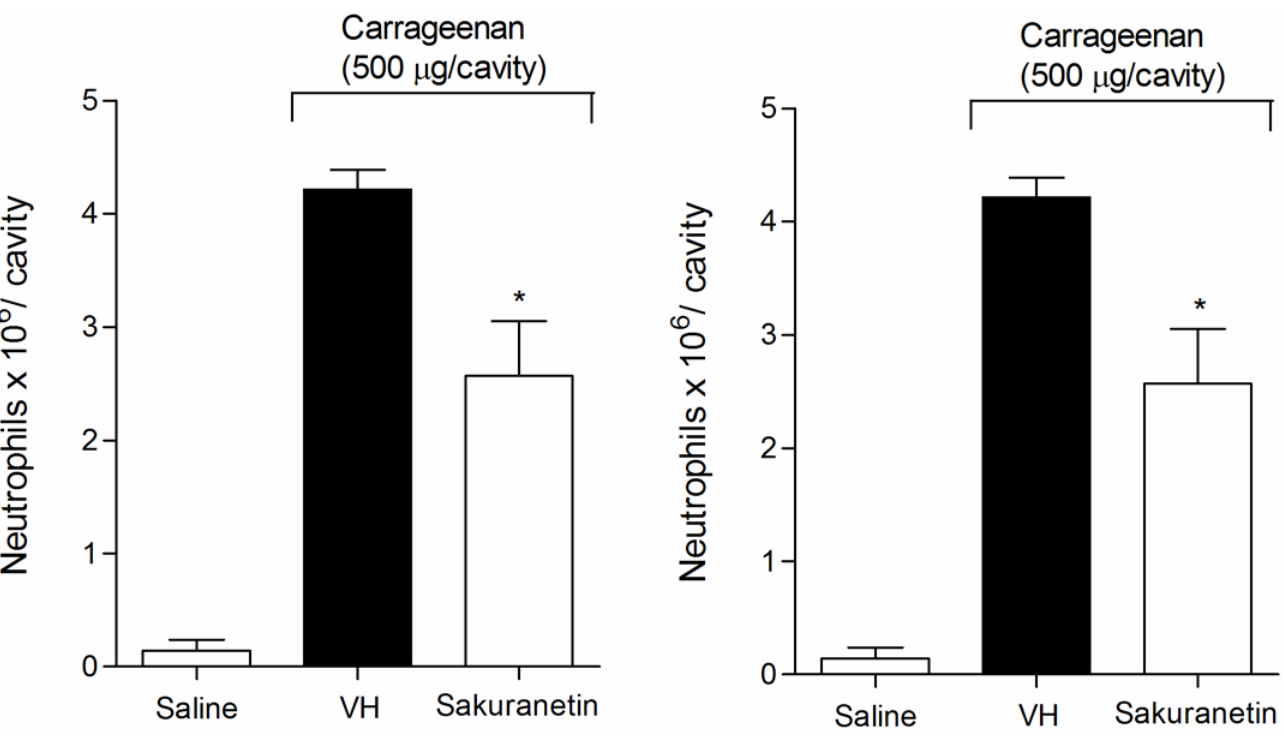
Fig 17. Effect of sakuranetin and synthetized isosakuranetin at a dose of 200 mg/kg on neutrophil recruitment to the peritoneal cavity of mice pretreated prior with Cg (500 μ g/ cavity). VH is the vehicle group (negative control). The results are presented as the mean ± S.D. (n = 8). Statistical significance was calculated by ANOVA followed by Bonferroni's test. * P < 0.05 compared to the vehicle-negative control treated group.